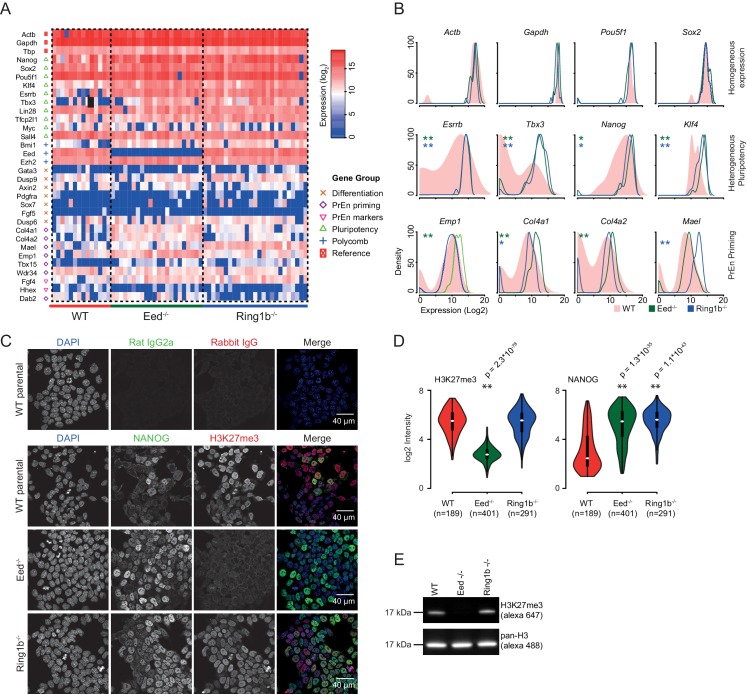
Polycomb deficiency results in reduced cell to cell expression heterogeneity of key pluripotency and PrEn priming genes.(A) Heatmap representing the log2 expression values for individual cells for each gene (columns and rows respectively) measured by single cell qRT PCR (see also Figure 3—figure supplement 1A). Dashed lines, group cells based on genotype (WT - light red, Eed-/- - green and Ring1b-/- - blue). (B) Density plots showing the per cell distribution of log2 gene expression values for each of the WT (light red), Eed-/- (green) and Ring1b-/- (blue) genotypes at a subset of key genes taken from (A). The expression profiles between WT and Eed-/- or WT and Ring1b-/- cells were assessed for significance using a Kolmogorov-Smirnov (KS) test under the null hypothesis that there was no shift in the distribution of expression values between these comparisons. Significant results are indicated (green and blue asterisks respectively; p values are presented in the left panel of Figure 3—figure supplement 1B). (C) Immunofluorescence labelling of NANOG (green) and H3K27me3 (red) in WT, Eed-/- andRing1b-/- mouse ESCs. Scale bar = 40 µm. (D) Violin plots showing the quantification of immunofluorescent signal presented in (C). For each cell line, three fields of view were analysed and significance of the differential signal between WT and mutant cells was determined using a Wilcoxon Rank Sum test. Significant results are indicated with asterisks. (E) Example immunoblot showing H3K27me3 levels relative to total H3 in the indicated polycomb mutant ESC lines.